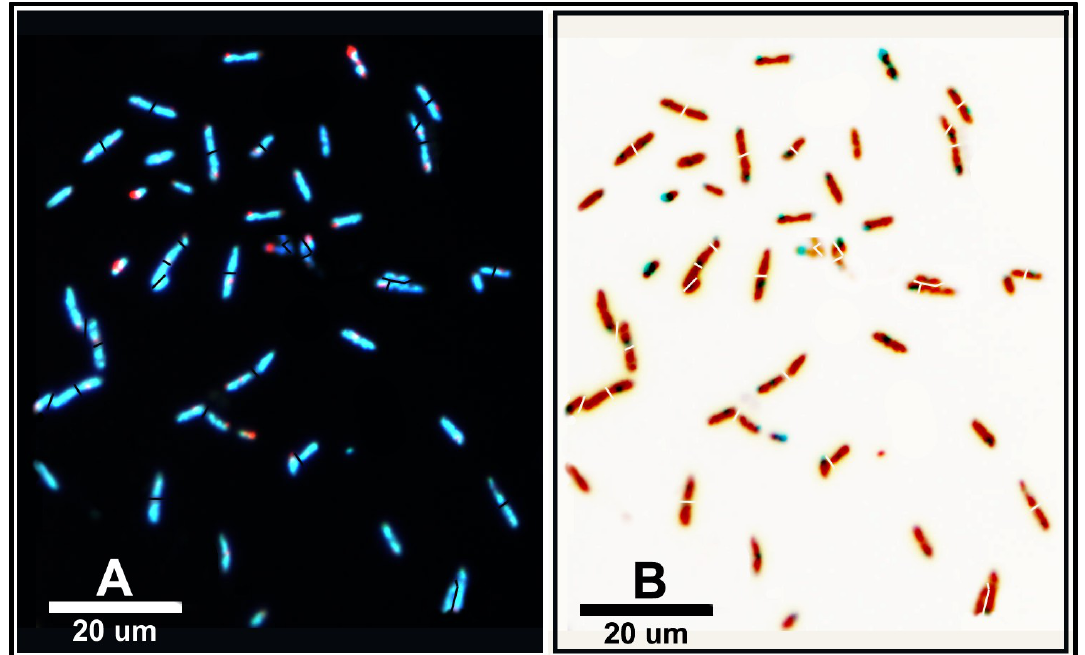
Figure 13. Use of color segmentation in ecophysiological studies of respiring bacteria. ( a ) All cells are stained blue with SYBR Gold and the actively respiring bacteria accumulate the CTC-reduced red fluorescent product. ( b ) The resultant image produced by a color segmentation protocol shows that a much larger percentage of the same cells were actively respiring (accumulated reduced product is now blue) than can be easily recognized by visual counting of cells with red reduced product in the original image